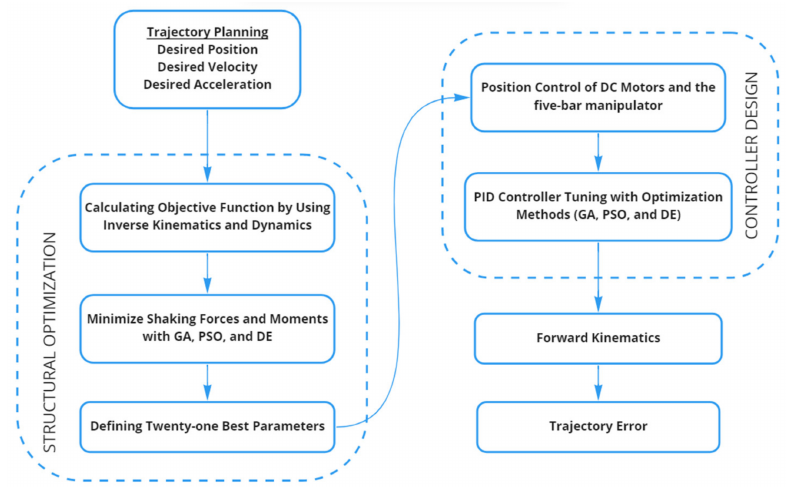
Figure 1. The layout of the simulation of the optimization algorithm.